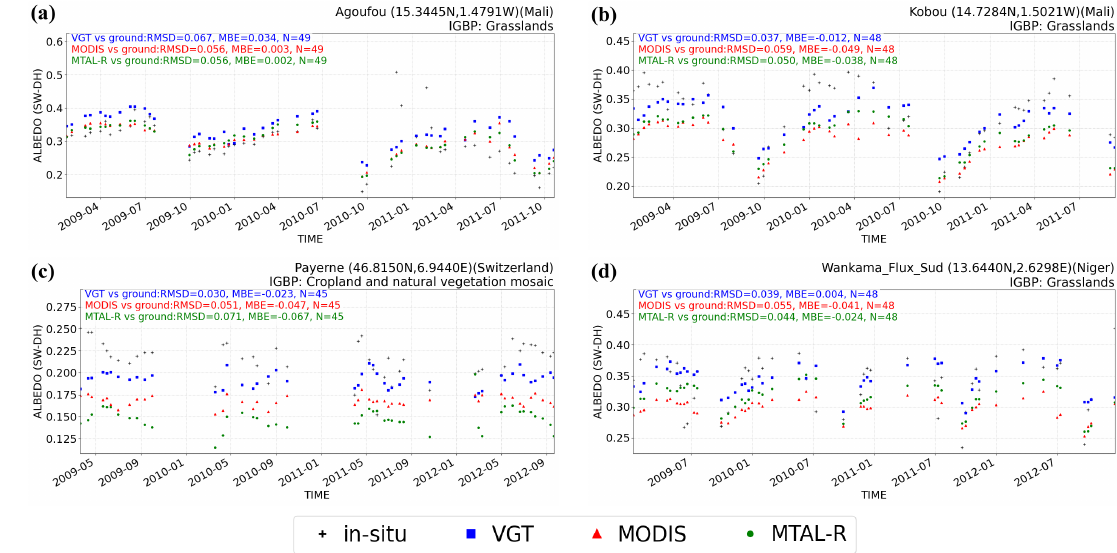
Figure 4. Time series of VGT (ten-daily) against ground measurements (daily) for a set of ground stations: ( a ) Agoufou; ( b ) Kobou; ( c ) Payerne; and ( d ) Wankama flux sud. Only those dates that provided concomitant data for all three satellites products and ground measurements were considered. MODIS- and MTAL-R-derived equivalent albedo measurements are also presented. Difference statistics (root-mean-square deviation (RMSD) and mean bias error (MBE)) between satellite estimates and ground measurements are included. N is the number of satellite albedo estimates for which a ground measurement is available (thus, the number of estimates used to calculate the statistics).